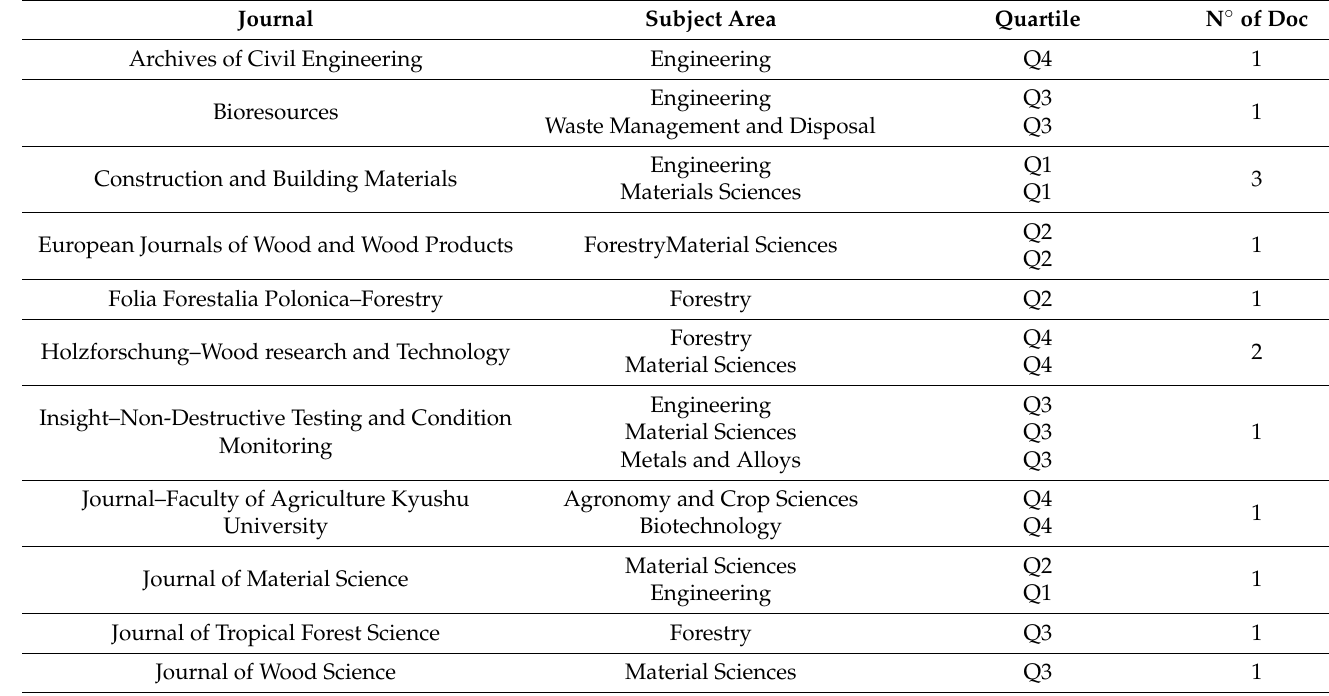
Table 2. Journal’s names, corresponding main subject areas, journal’s quartile and number of published documents for each journal.